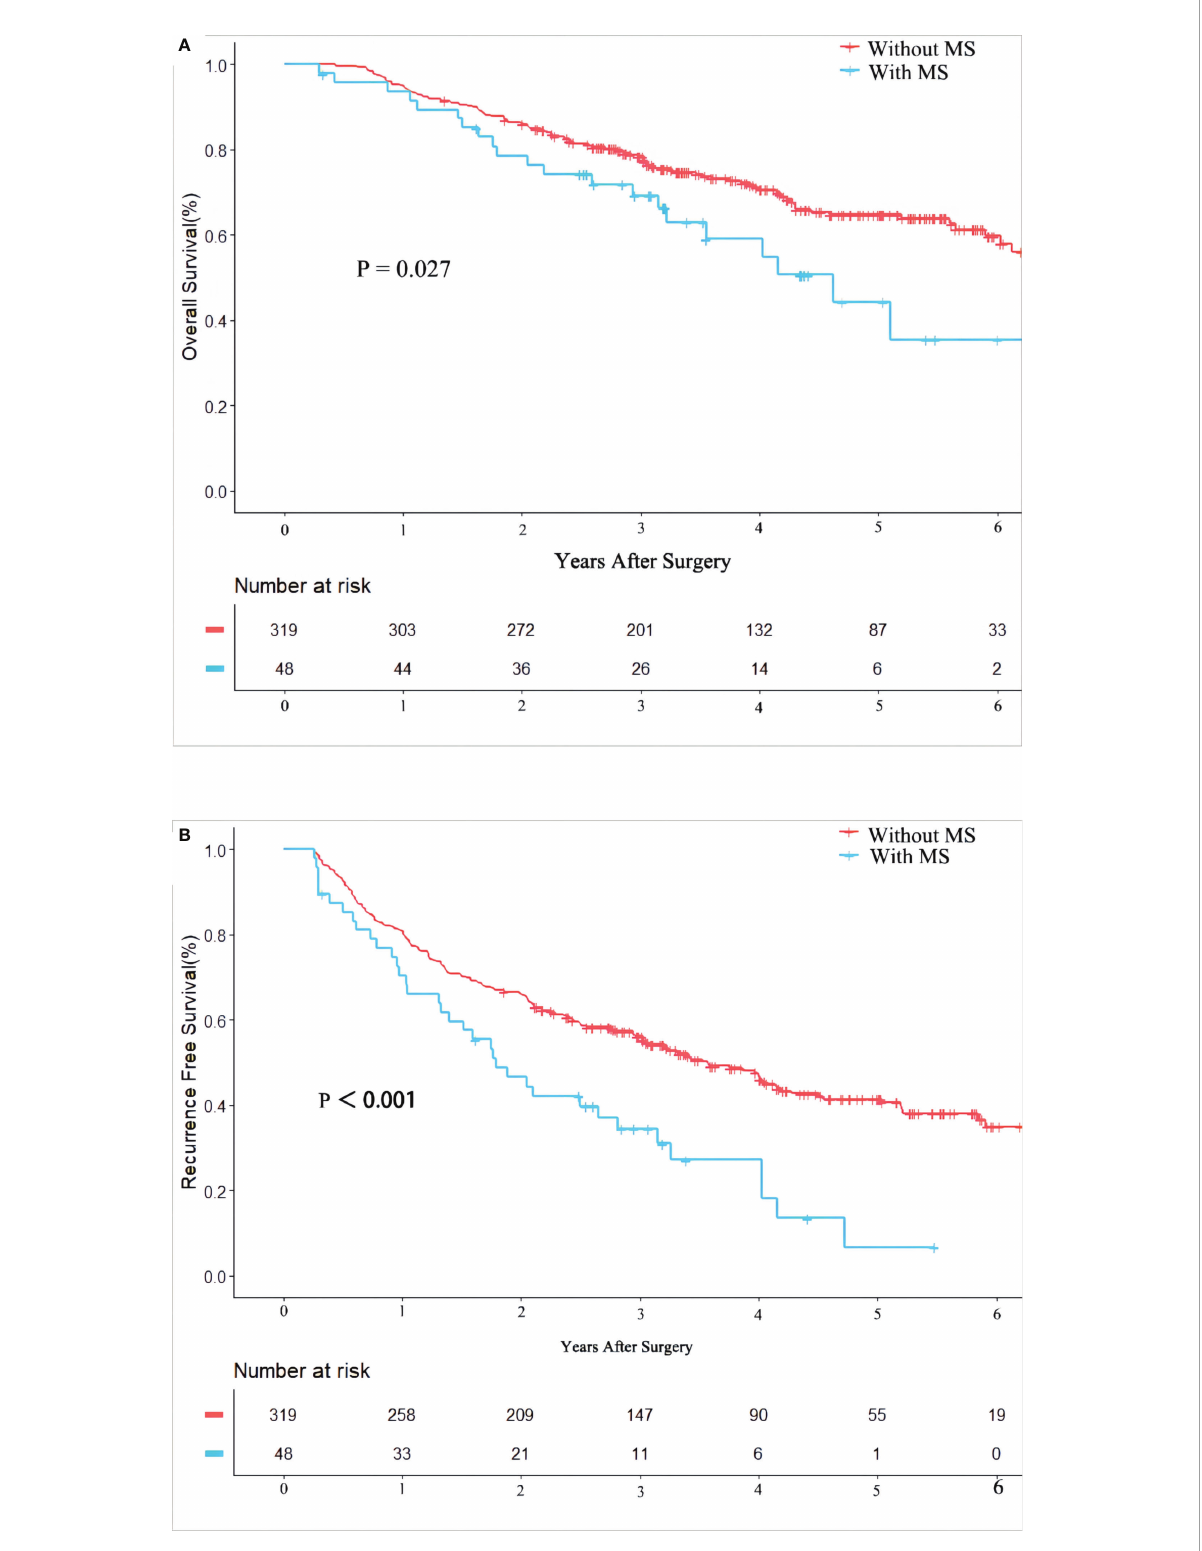
FIGURE 1 Kaplan-Meier Curves of overall survival (A) and recurrence free survival (B) between HBV-infected patients with and without metabolic